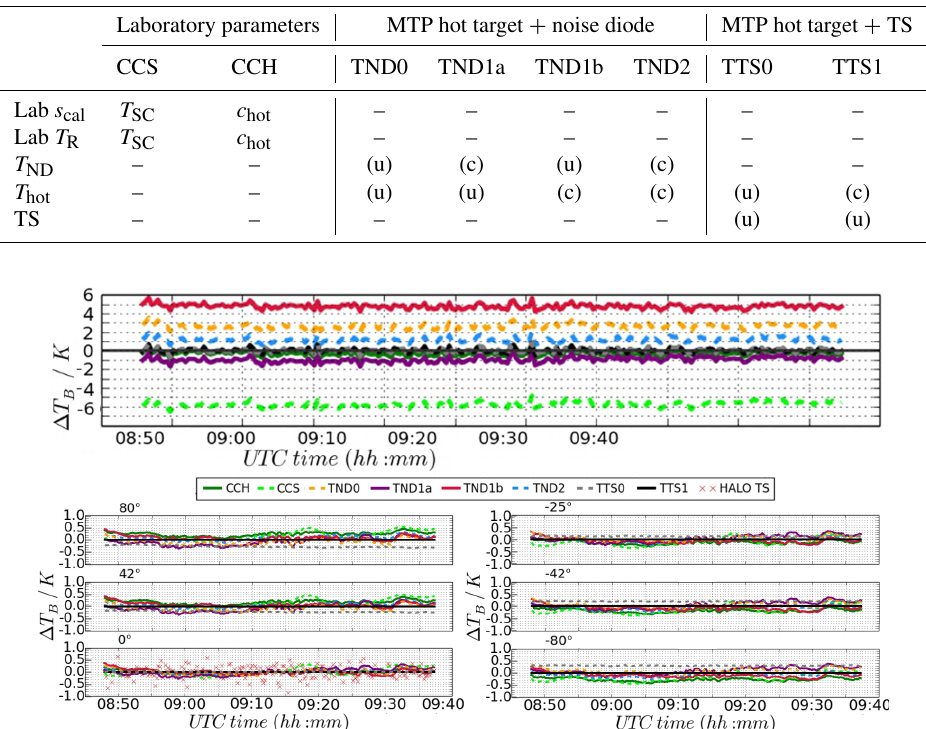
Figure 10. Top panel: difference between HALO static temperature and TBs derived with the eight calibration methods defined in Table 6 derived from the horizontal measurements at 56.363GHz during one segment of an ML CIRRUS mission flight. Lower part: same as the top, but plotted relative to method TTS1 and with an applied offset correction at six different elevation angles measured at 56.363GHz. Red crosses in lower left panel: difference between method TTS1 and HALO TS. Refer to Table 6 for the denomination of the calibration